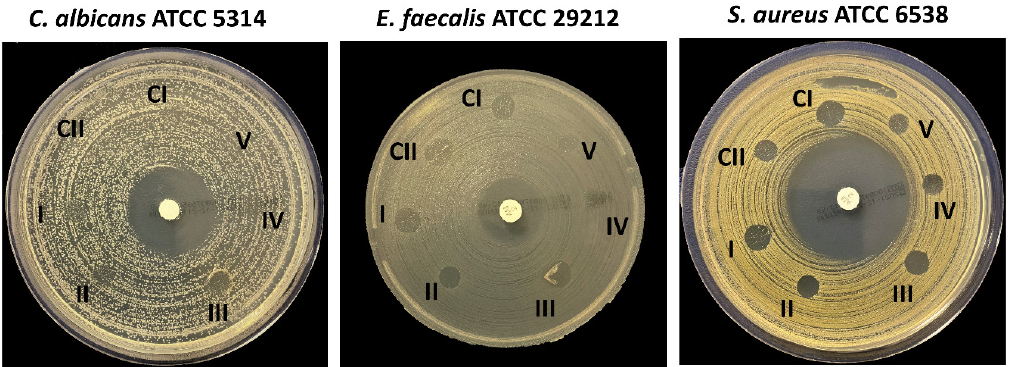
Figure 11. The antimicrobial activity results of the control groups and PPE: PSE scaffolds. CI: Control 1; CII: Control 2; I: 13% PVA/2% S/3% PE; II: 13% PVA/2% S/5% PE; III: 13% PVA/2% S/7% PE; IV: 13% PVA/2% S/9% PE; V: 13% PVA/2% S/11% PE. On the other hand, 13% PVA/2% S/9% PE and 13% PVA/2% S/11% PE scaffolds did not show increased antimicrobial activity compared to the 13% PVA/2% S/3% PE, 13% PVA/2% S/5% PE and 13% PVA/2% S/7% PE scaffolds. Moreover, there was no inhibition zone around the 13% PVA/2% S/9% PE and 13% PVA/2% S/11% PE scaffolds against the E. faecalis . According to the results, it was noticed that pomegranate seed and peel extracts have a noticeable antimicrobial activity on both S. aureus and E. faecalis . It can be concluded that PPE: PSE has a significant antimicrobial effect. However, further research needs be conducted on a large quantity of infections to determine how exactly PPE: PSE impacts species. Table 4. The inhibition zone diameters of the control groups and scaffolds. Group Number